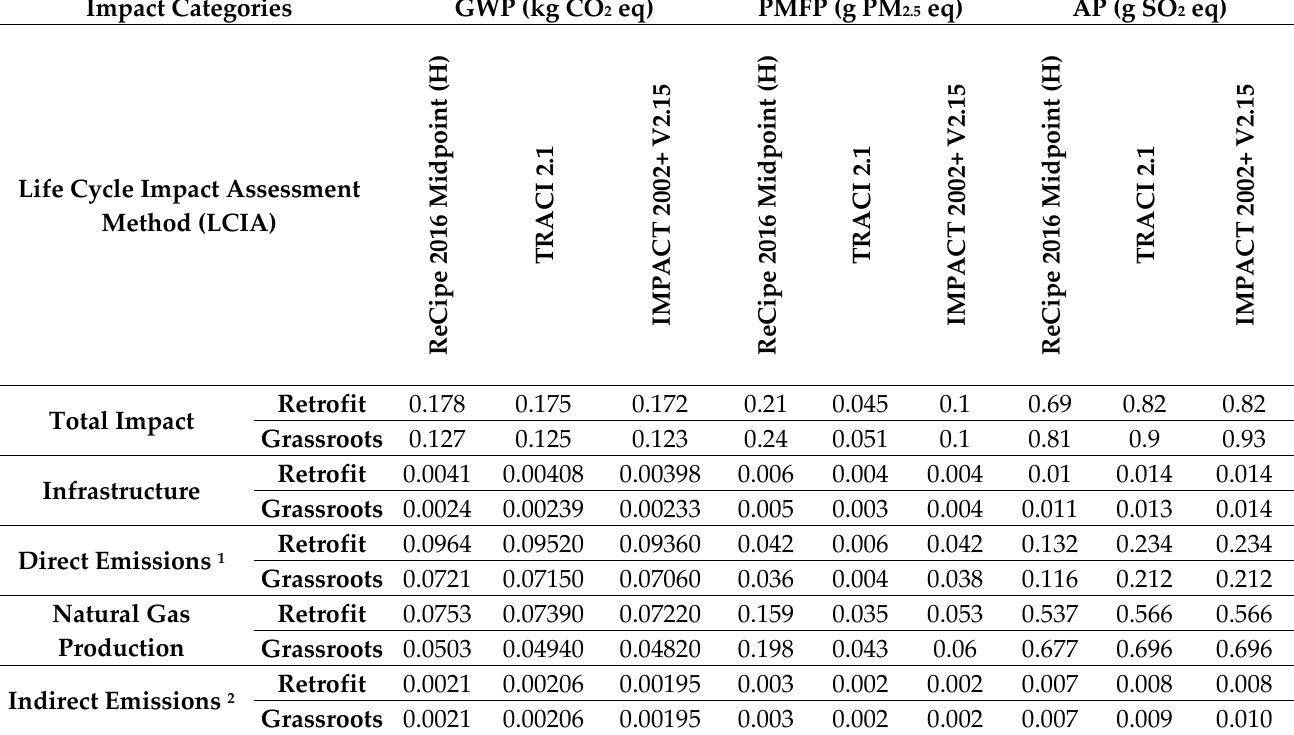
Table 6. Absolute characterization scores using various methods.